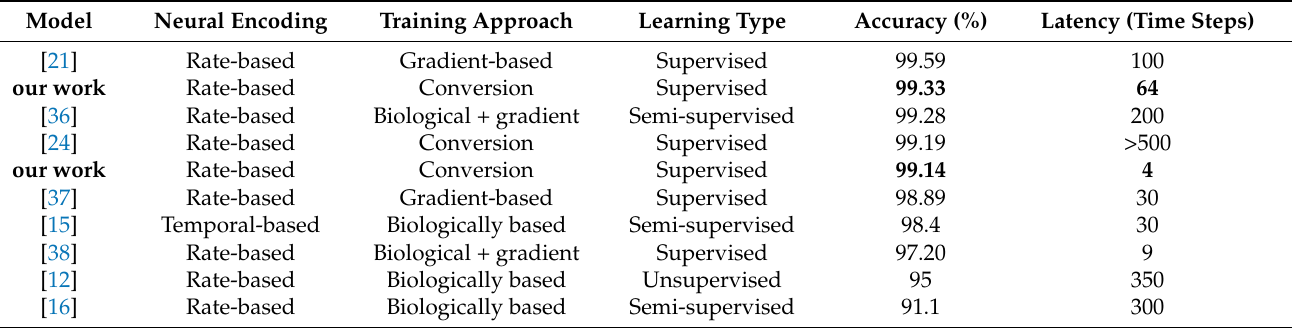
Table 5. Performance of the recent SNN models for the MNIST